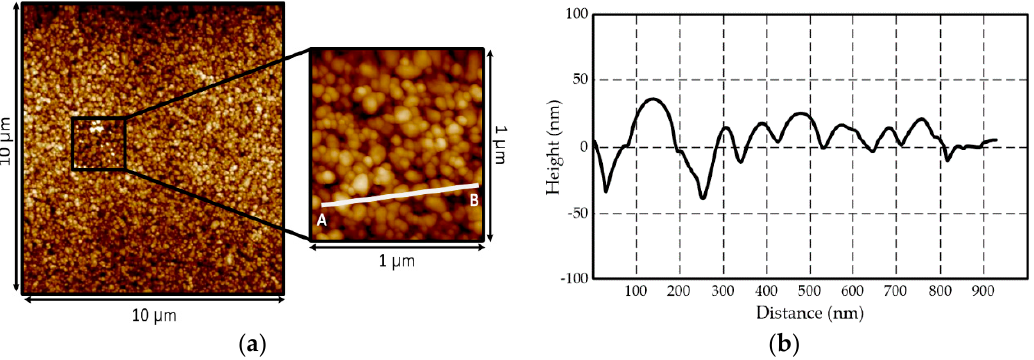
Figure 2. Surface of the inkjet-printed silver nano-particles: ( a ) Atomic force microscope (AFM) images of 10 µm × 10 µm and 1 µm × 1 µm areas, and ( b ) cross section of the line AB.